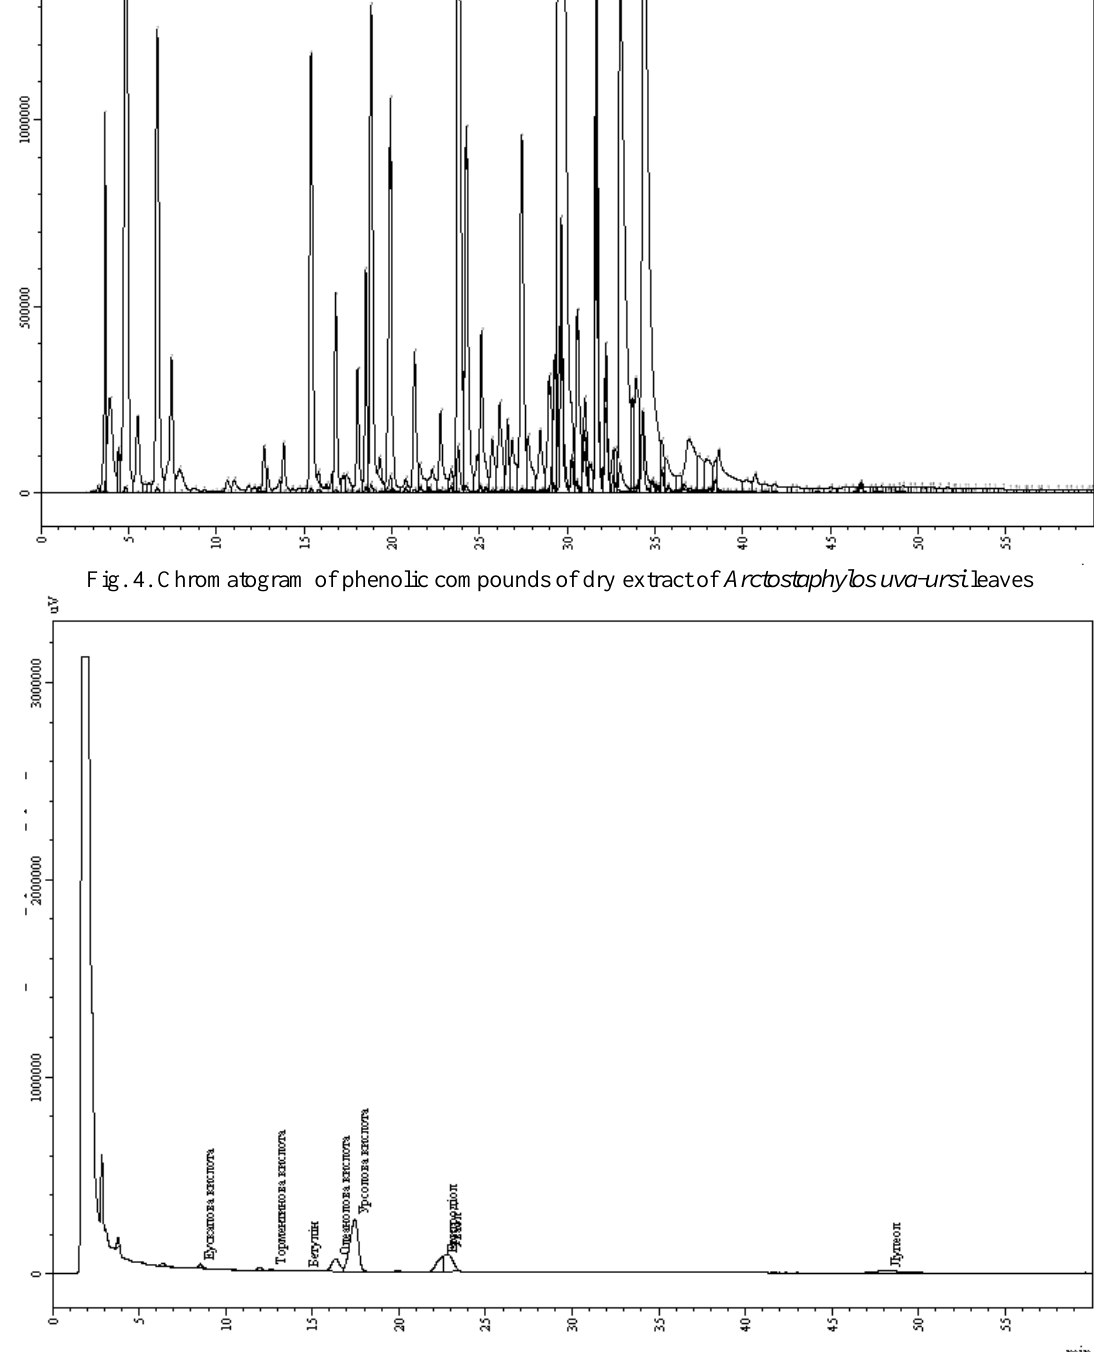
Fig. 5. Chromatogram of saponins of dry extract of Arctostaphylos uva-ursi